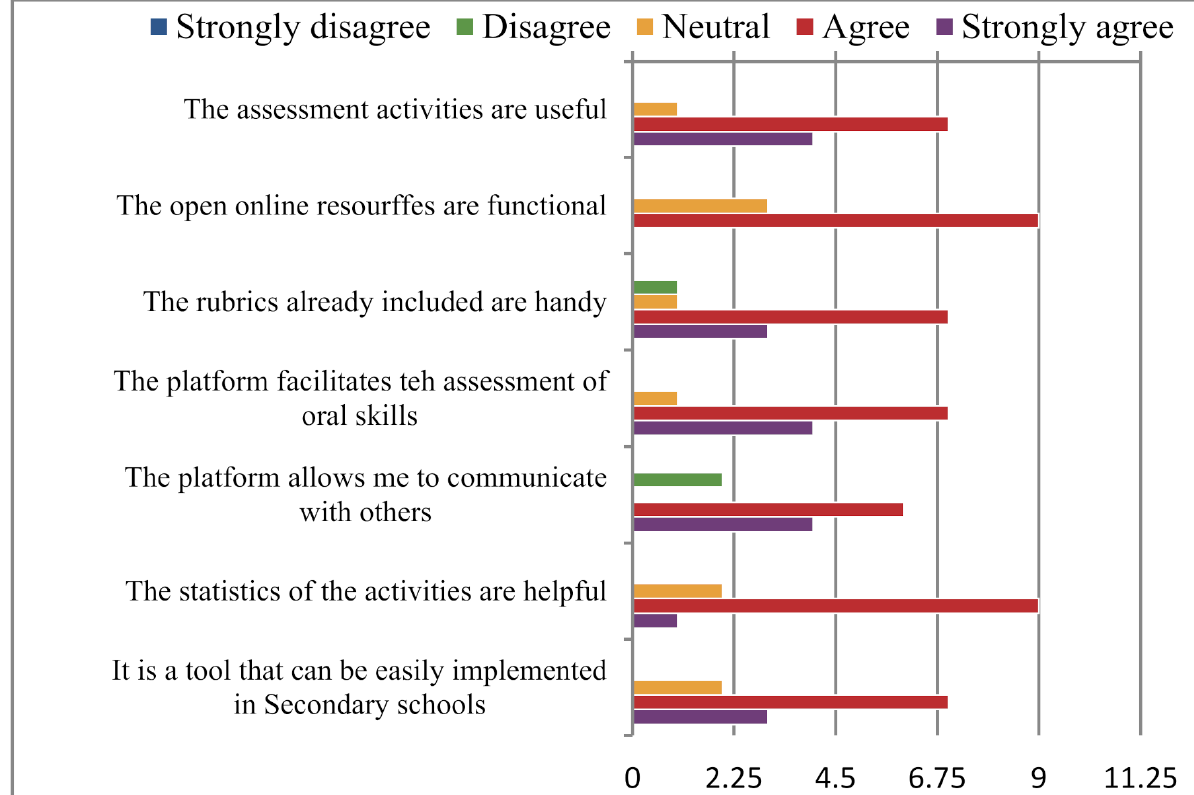
Figure 4. Evaluation phase 2. Educational